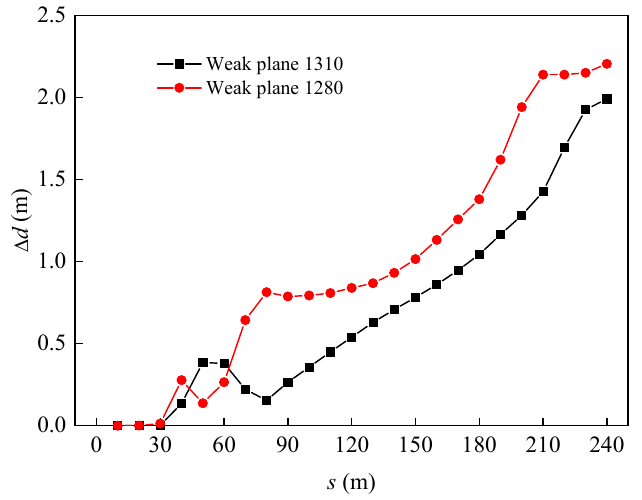
Figure 13. Relation between weak-plane slipping distance and working face advancing distance.